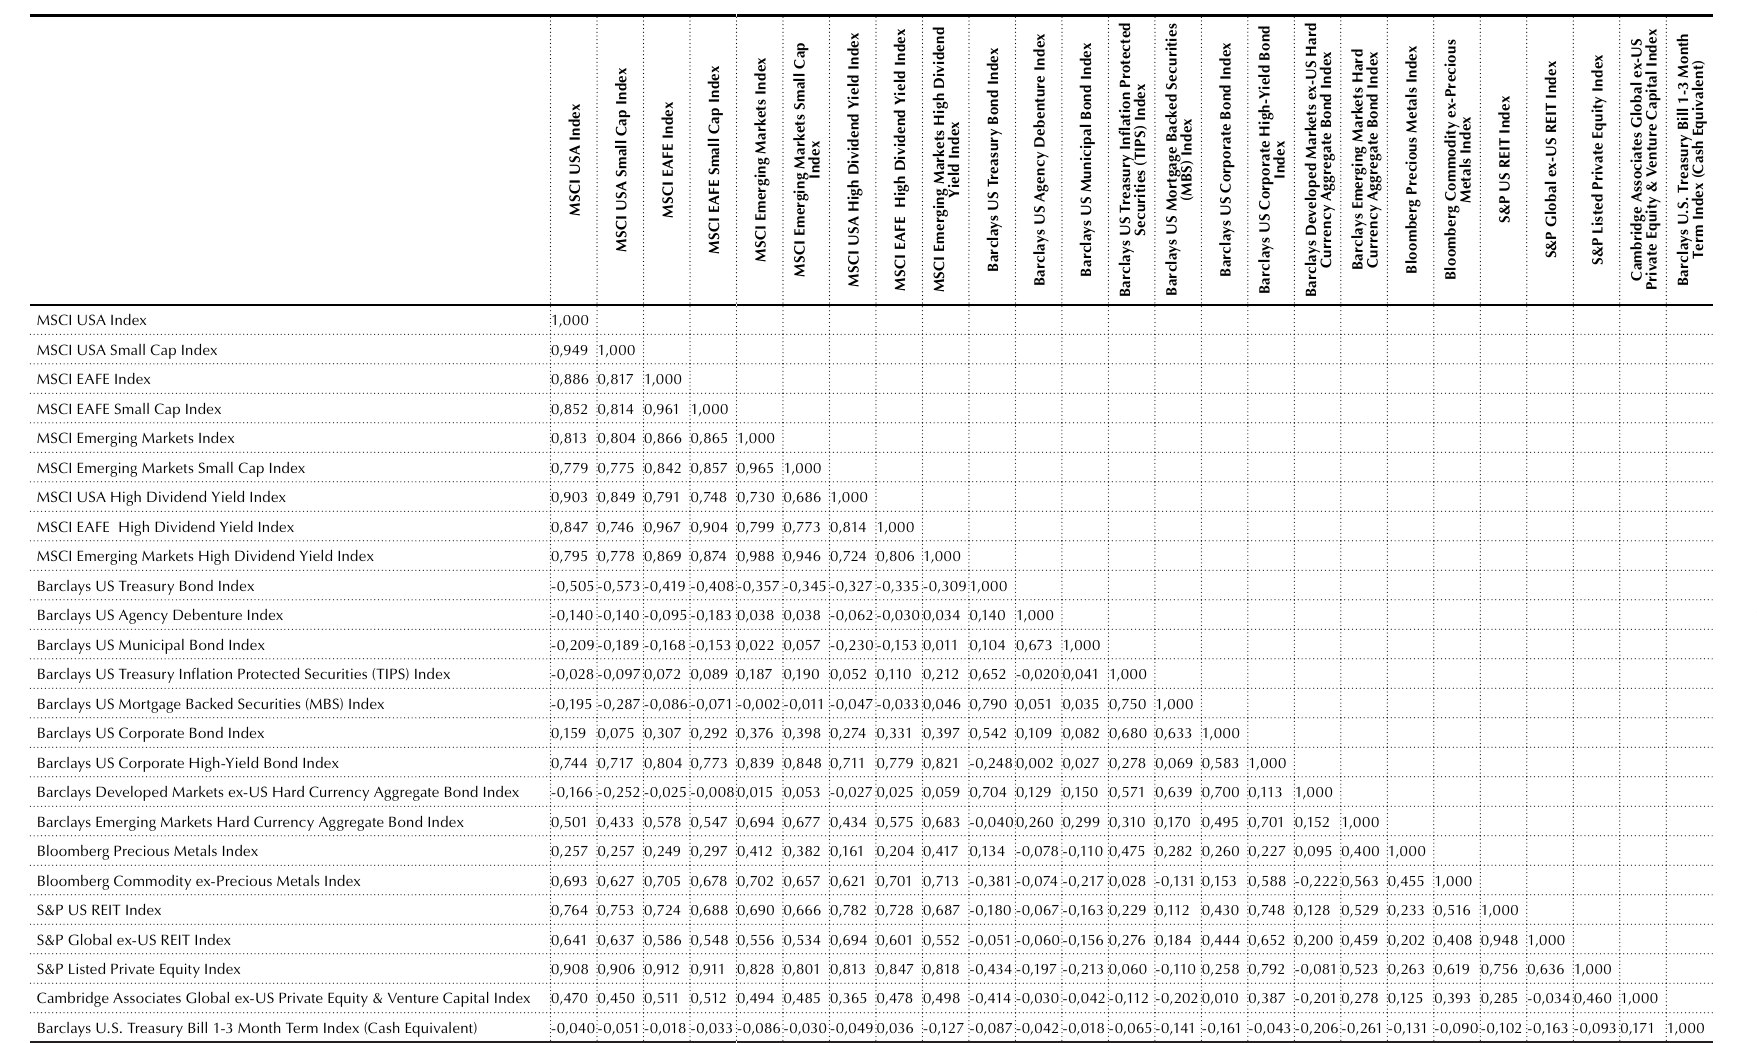
Table A2. Correlation matrix of excess